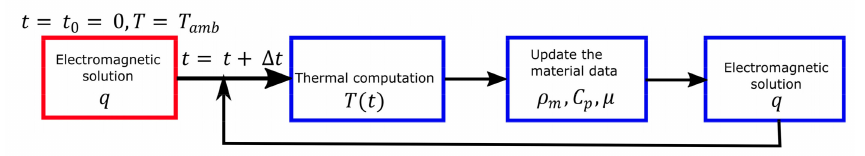
Figure 2. Flow chart of the procedure for solving coupled electromagnetic-thermal